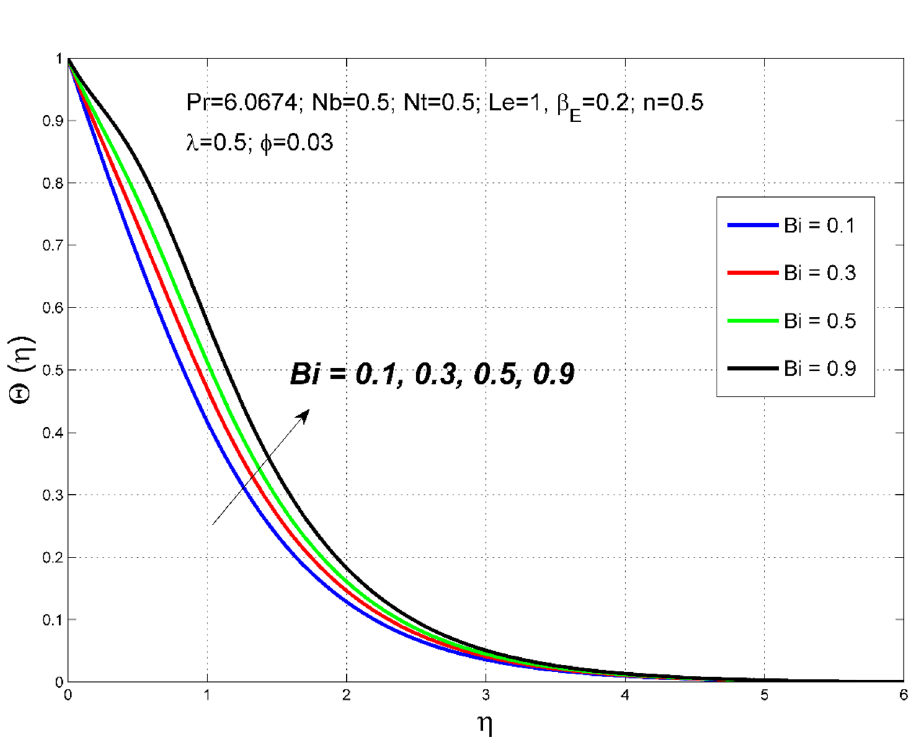
Figure 6. The nanoparticles volume fraction distribution �(η) behavior for the variation of the Biot number Bi